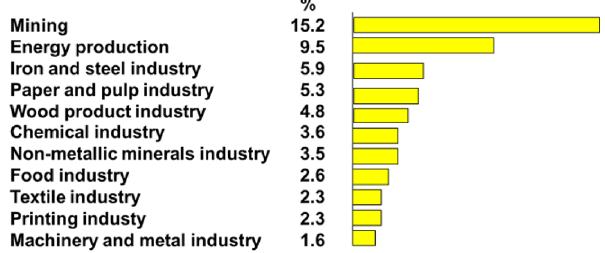
Fig. 4 Maintenance costs in industrial sectors in Finland in 1997.